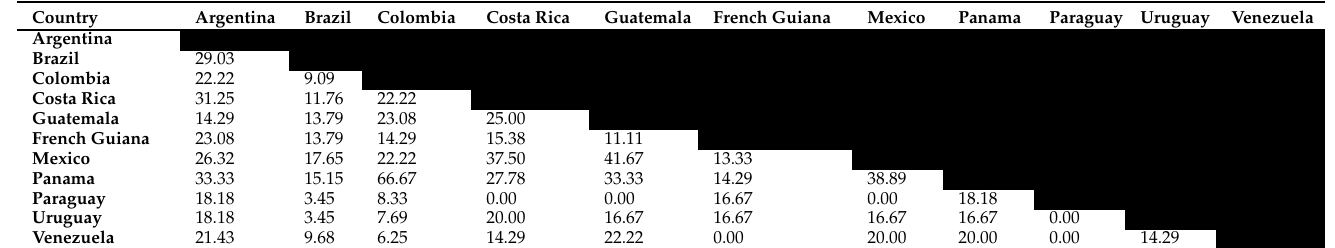
Table 3. Arbovirus similarity index according to Jaccard’s index among Neotropical countries.